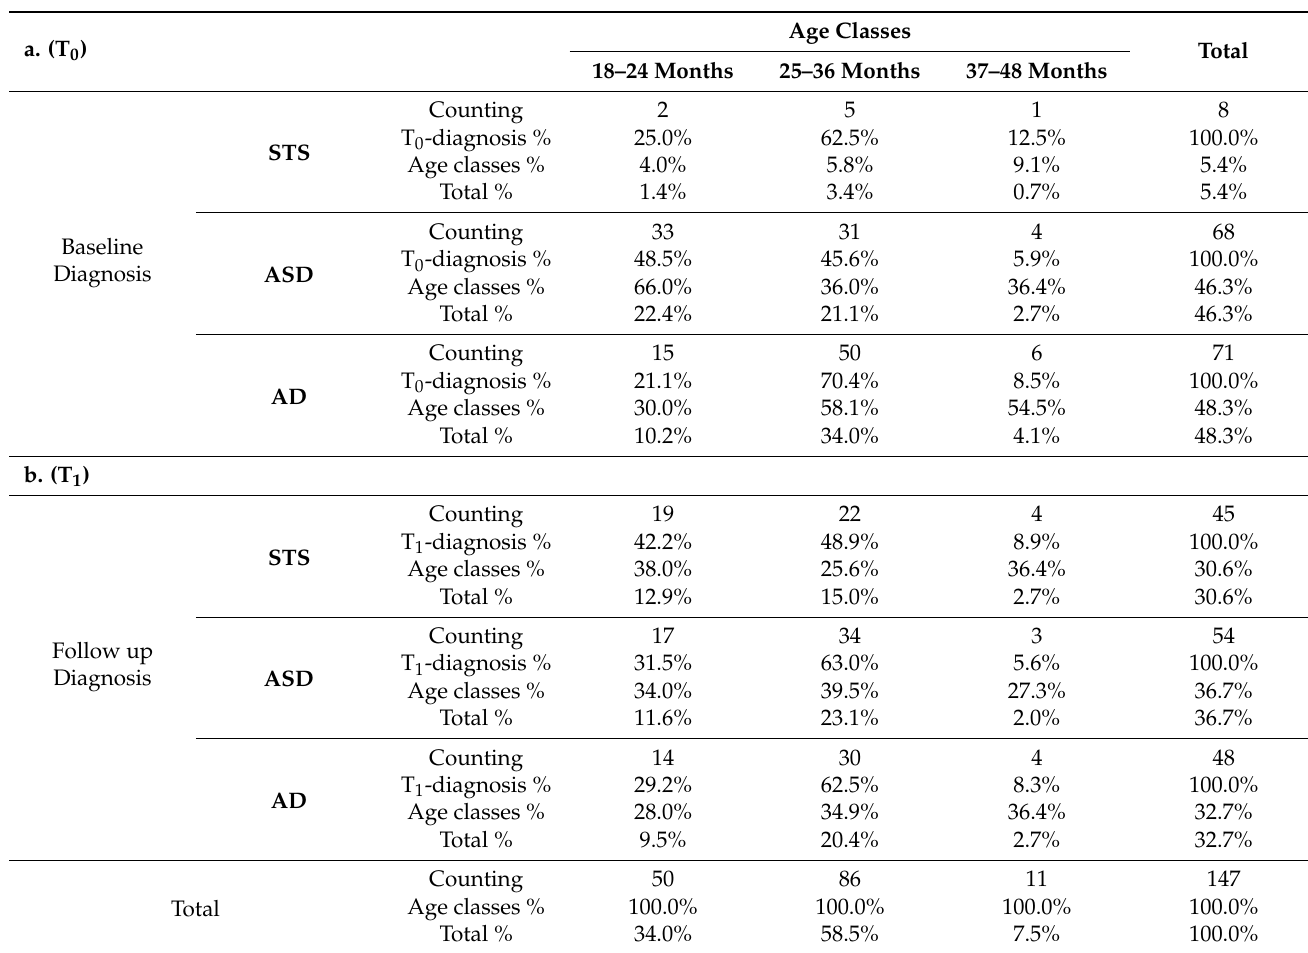
Table 1. Baseline (T 0 ) and follow-up (T 1 ) diagnosis categories by age classes.